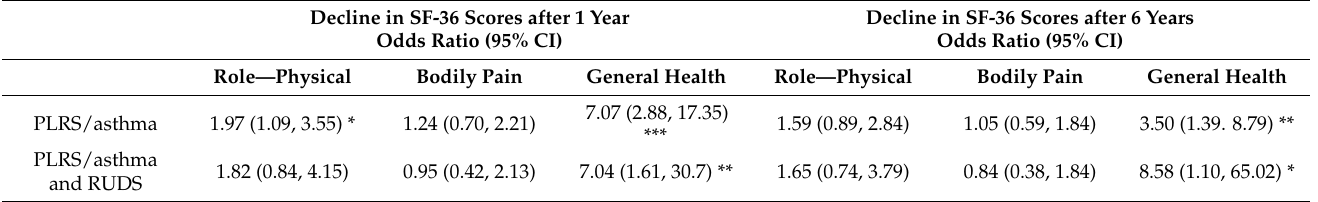
Table 5. Determinants of decline in health-related quality of life in physical health according to SF-36 subscale scores of Macassar residents ( n = 246) at 1 year and 6 years after the fire incident using multivariate logistic regression